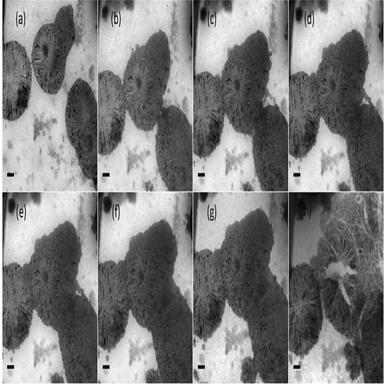
Liquid cell TEM images showing the growth of C-S-H precipitates at different times: (a) 2 h 42 min, (b) 2 h 54 min, (c) 3 h 03 min, (d) 3 h 09 min, (e) 3 h 14 min, (f) 3 h 29 min, (g) 4 h 08 min and (h) 4 h 46 min (scale bars, 0.5 μm). Image reproduced from .